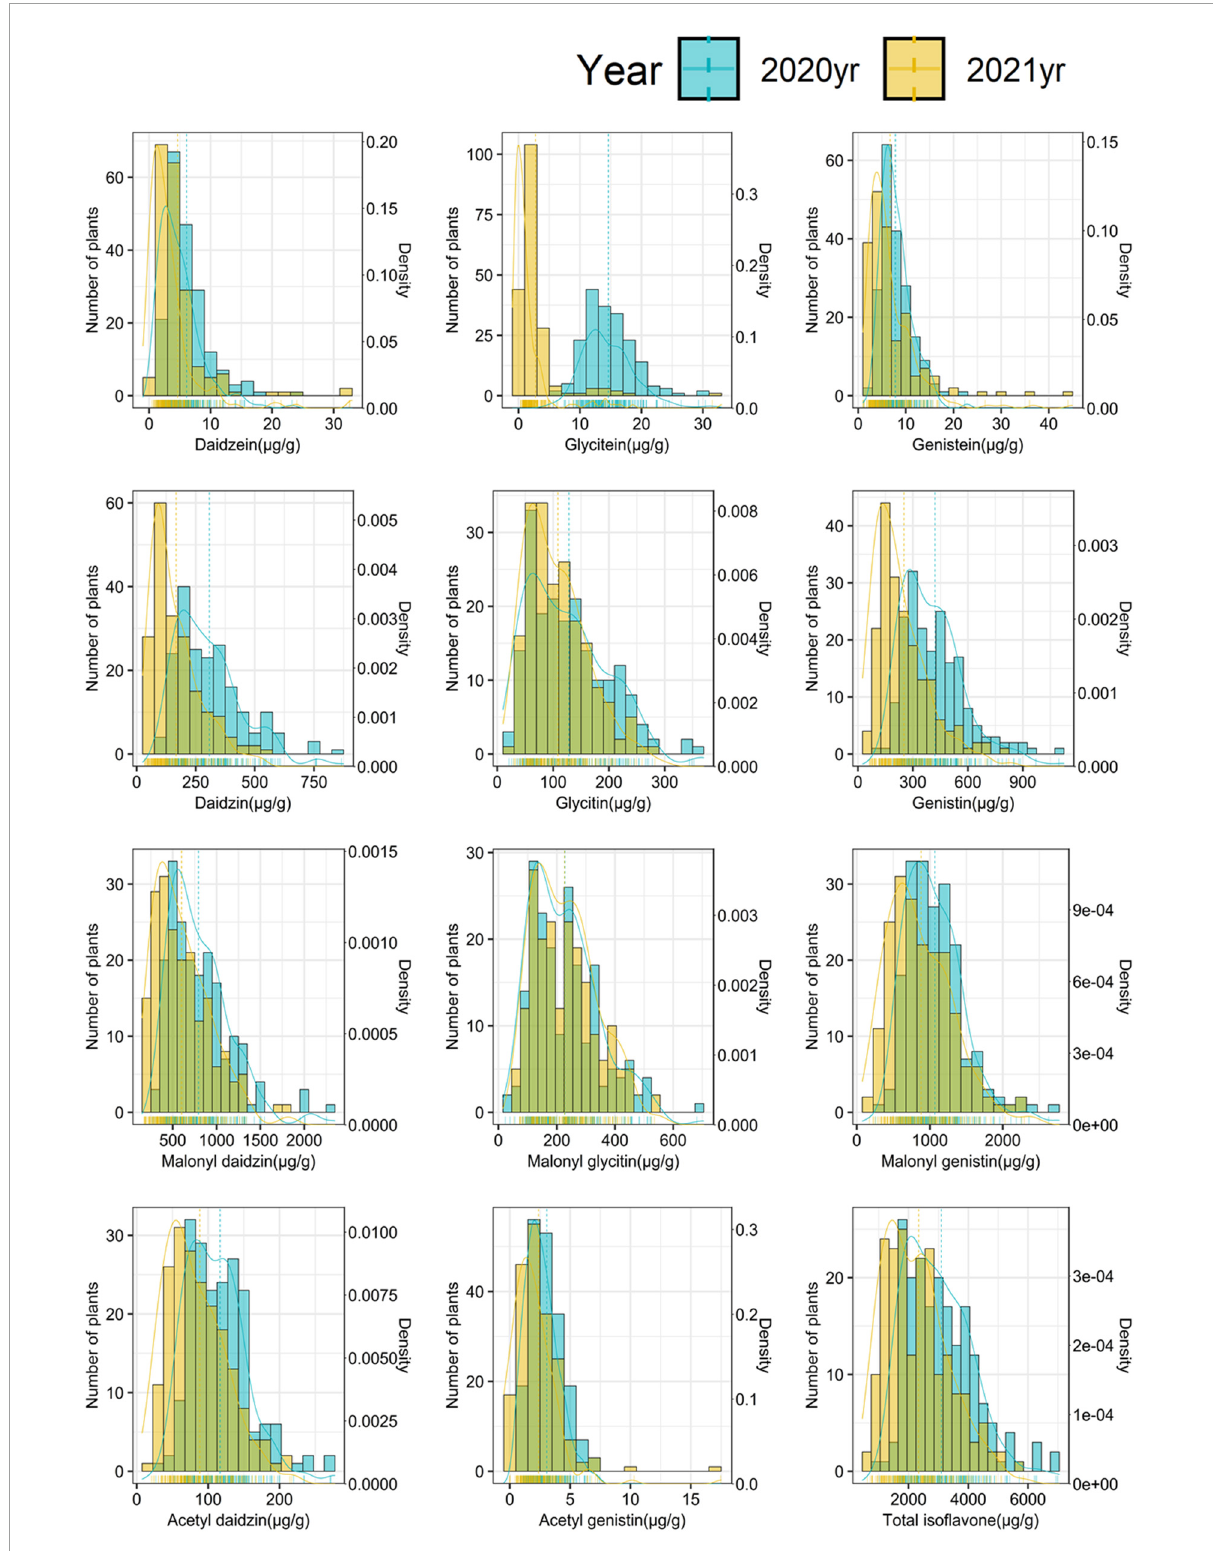
FIGURE1 Frequency distribution of individual isoflavones and total isoflavone contents in mutant diversity pool (MDP).